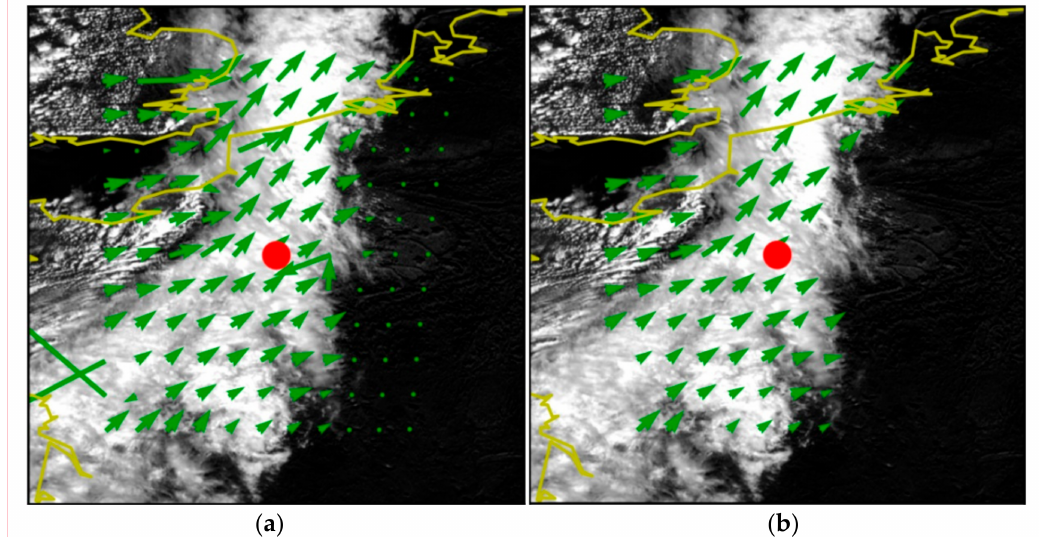
Figure 3. Motion vectors without ( a ) and with ( b ) consistency tests (image acquired the 6 April 2020 at 12:00 UTC). The red spot cross locates the SIRTA